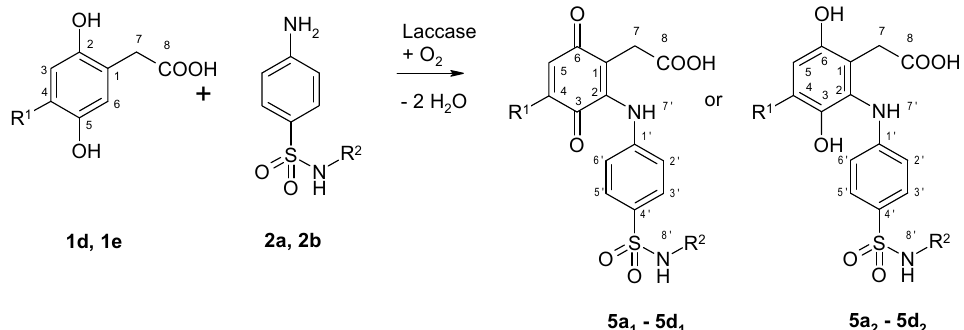
Table 1. Heterodimers and heterotrimers produced by laccase-mediated reactions of 2,5-dihy-